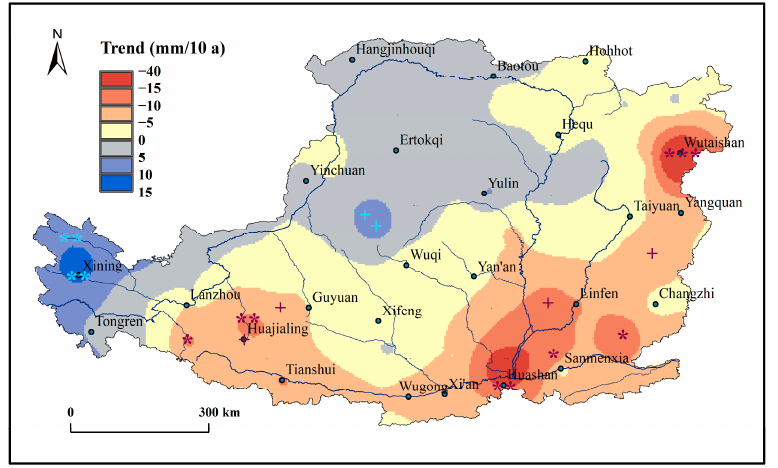
Figure 2. Spatial trend of annual precipitation (mm/10 a) across the Loess Plateau during 1957–2018. The blue symbols represent increasing trend and the red represent decreasing trend. The symbols of +, *, **, *** mean passing the significance level of 0.1, 0.05, 0.01, and 0.001, respectively.